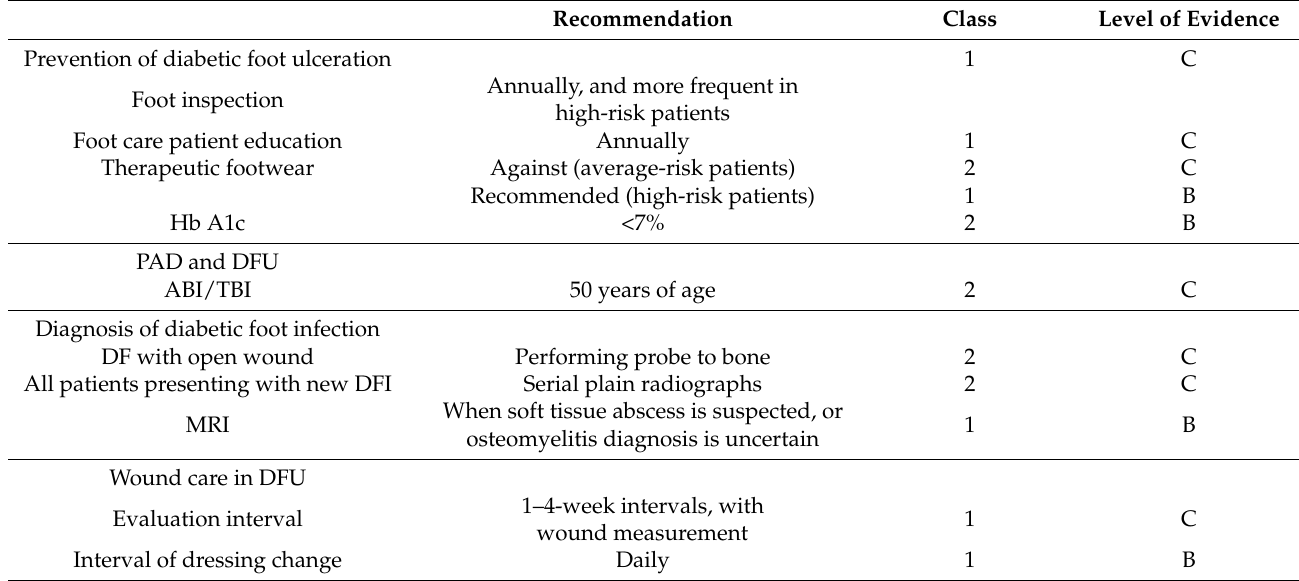
Table 2. Current clinical practice guidelines by the society of vascular surgery in collaboration with the American Podiatric Medical Association and Society for Vascular medicine about the management of diabetic foot